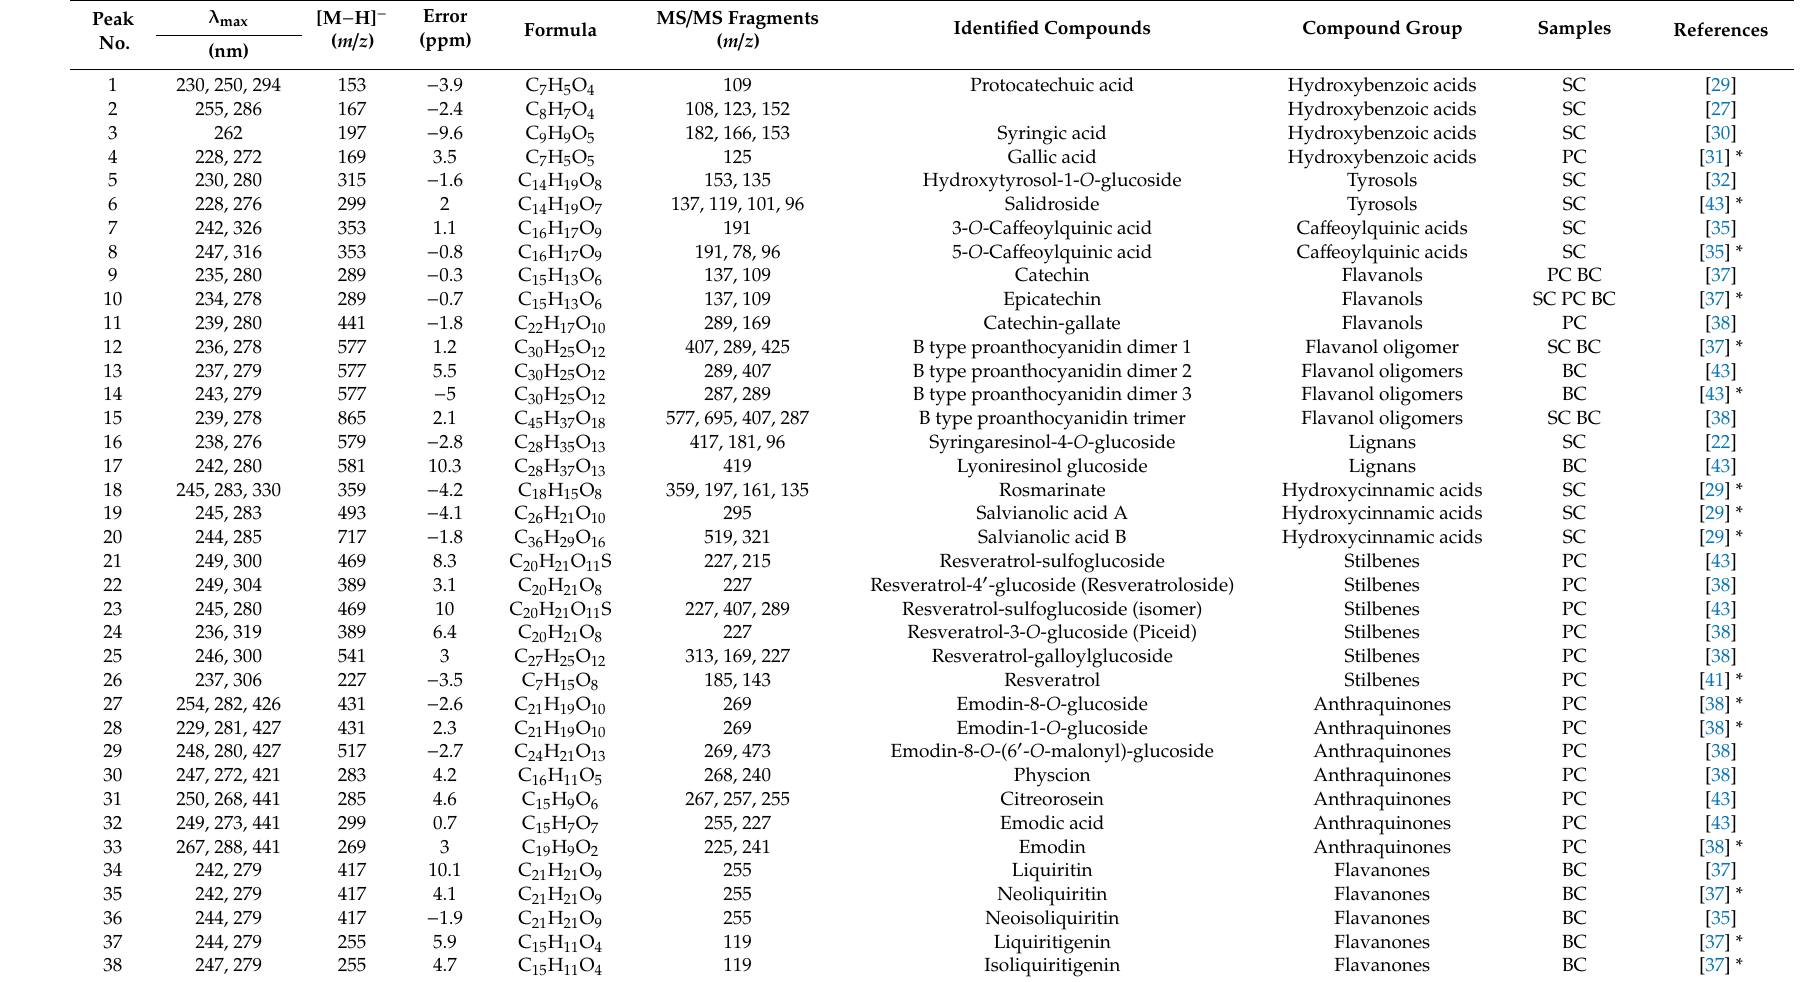
Table 1. Phenolic compounds tentatively identified with UPLC-DAD-QTOF-MS / MS Peak